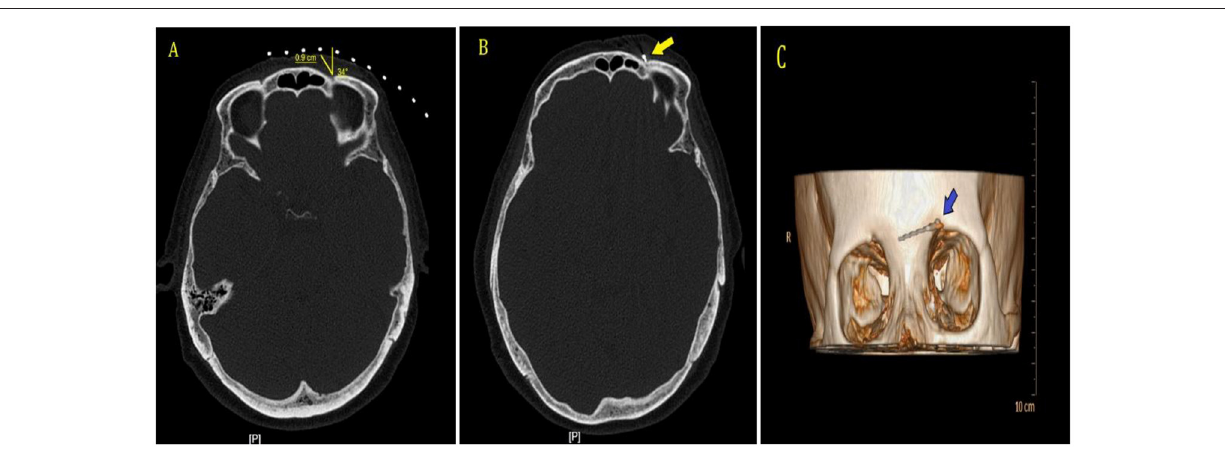
FIGURE 2 | CT guidance and 3D reconstruction. (A) CT scan was performed to establish puncture point and needle path. (B) CT scan showed that the radiofrequency needle was located in the left supraorbital foramen, shown by the arrow. (C) 3D-CT showed the radiofrequency needle was located in the left supraorbital foramen, shown by the